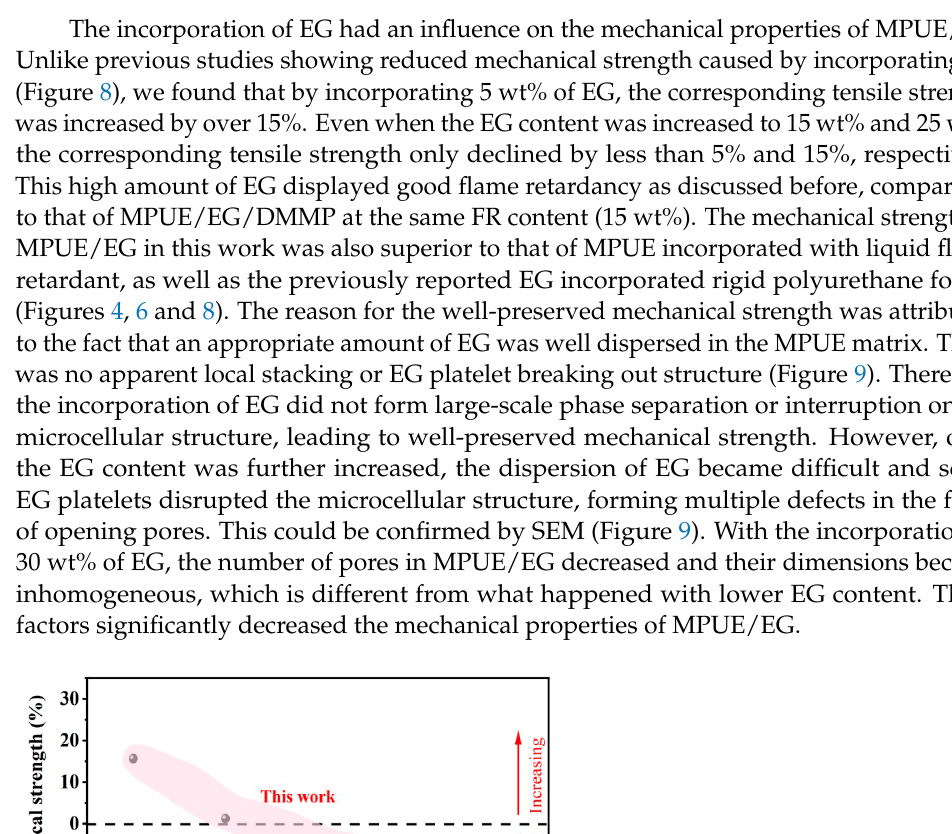
Figure 7. The residual carbon layers of ( a ) MPUE/EG and ( b ) MPUE/EG/DMMP.